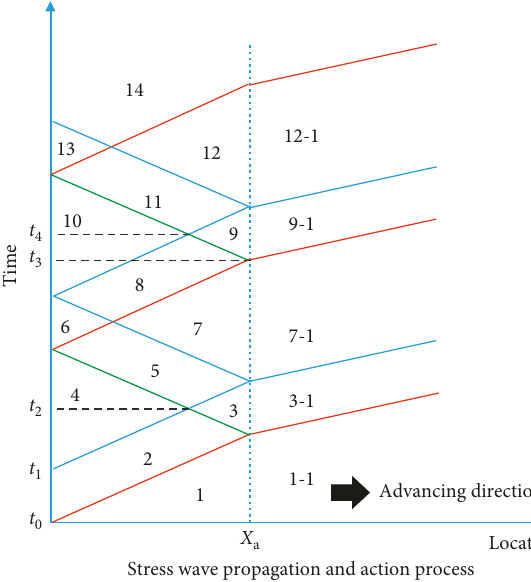
Figure 5: Stress wave propagation and action process in elasto- plastic